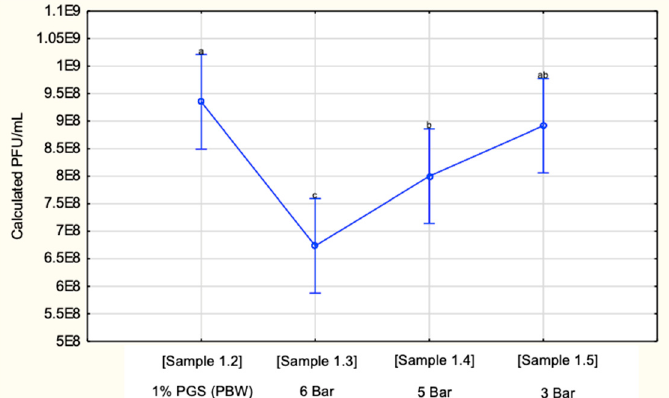
Figure 3. Calculated PFU/mL of 1% PGS (PBW) before being sprayed (sample 1.2) through the mesh (200) and nozzle (530 μ m) at pressures of 6, 5, and 3 Bar (sample 1.3–1.5). Sample 1.1. (100%) PGS had an average PFU/mL of 2.82 × 10 11 , which is close to the